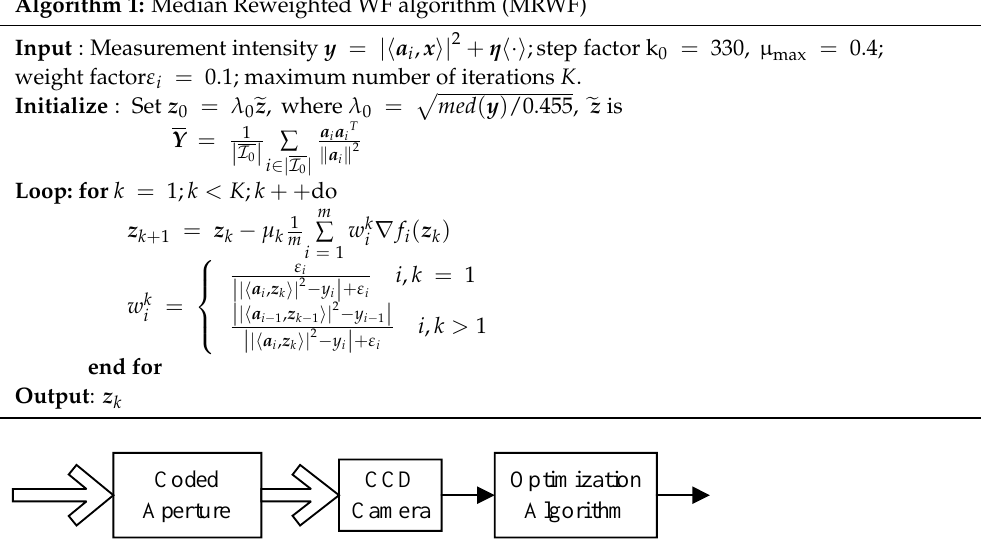
Figure 2. Structure of the sensing part of an adaptive optical system based on a non-convex optimization algorithm.